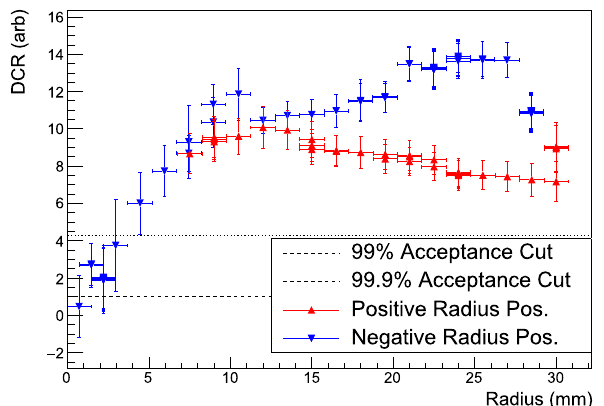
Fig. 8 The centroids of the DCR peaks in each data set; certain posi- tions were studied in multiple data sets. Negative (positive) radius posi- tions are indicated by blue downward-pointing (red upward-pointing) triangles. The vertical error bars give the 5 σ -width of the DCR dis- tribution peaks, and the horizontal errors depict the 0.75mm estimated uncertaintyofthesourceposition.Thedashed(dotted)lineindicatesthe 99% (99.9%) bulk event acceptance DCR cut. The observed instability of the DCR peak position is discussed in Appendix E